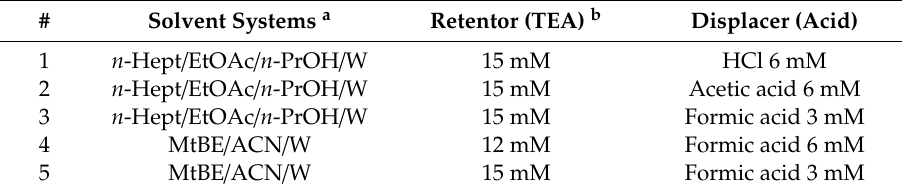
Table 2. Di ff erent solvent systems used for purification of Rhodolirium speciosum alkaloids by pH- zone-refinement centrifugal partition chromatography